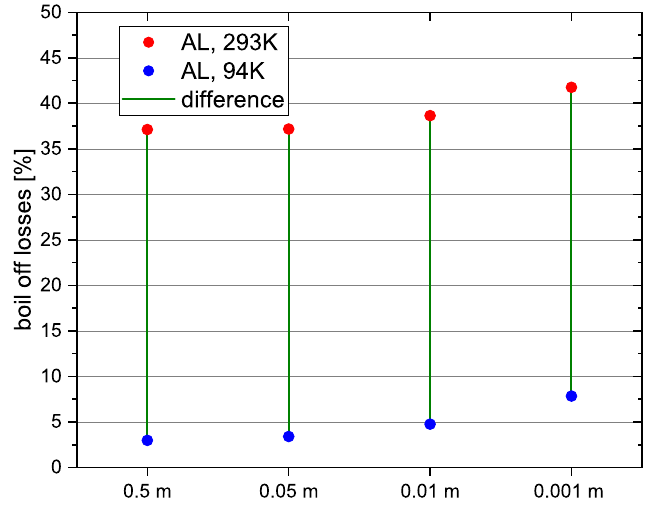
Figure 12. Relvative boil-off losses for different insulation thickness.